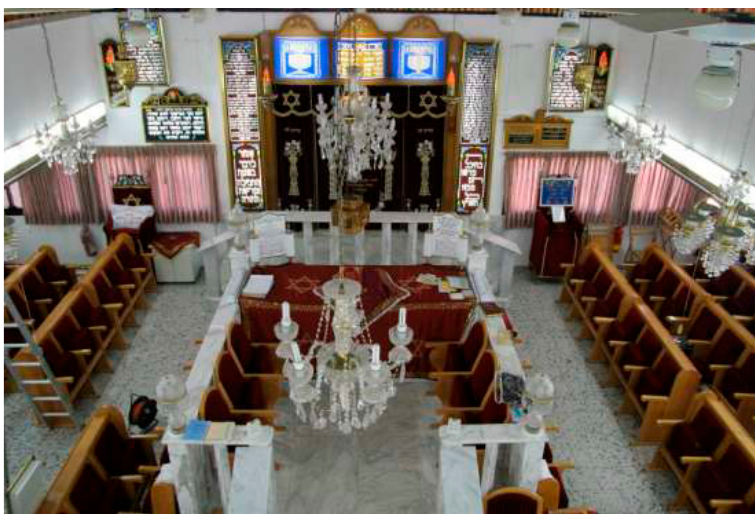
Figure 7. Interior, Magen HaShalom synagogue, Ramle (photo: the author, 2006).